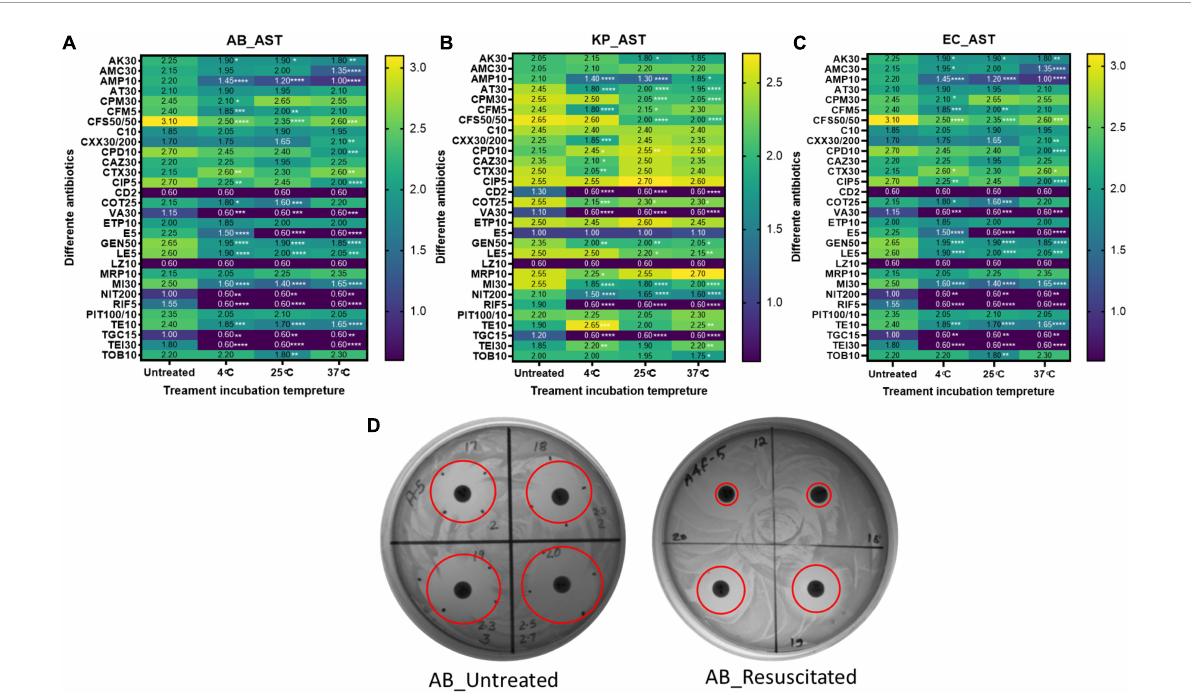
FIGURE6 AST profiling. The antimicrobial susceptibility pattern of resuscitated bacteria was checked by the disk diffusion method. AST pattern on the basis of the zone of inhibition diameter among untreated and formic acid (FA)-treated cells at 4, 25, and 37 ◦ C for panel (A) Acinetobacter baumannii , (B) Klebsiella pneumoniae , and (C) E. coli are shown here. Panel (D) is a representation of the disk diffusion agar plate of FA treatment at 4 ◦ C in A. baumannii with reduced clear zone diameter (in cm) in resuscitated bacteria. Statistical significance of diameter changes was determined by two-way ANOVA with multiple comparison followed by correction with Dunnett’s multiple comparison test using GraphPad Prism version 9.0.0. FA, formic acid; GC, growing control; NVC, non-viable control; 4C, sample incubated at 4 ◦ C; 25C, sample incubated at 25 ◦ C; 37C, sample incubated at 37 ◦ C; AB, Acinetobacter baumannii ; KP, K. pneumoniae ; EC, E. coli ; AK30, Amikacin (disk); AMC30, Amoxiclav (Amoxicillin/Clavulanic acid) disk; AMP-10, Ampicillin (disk); AT-30, Aztreonam disks; CPM50, cefepime disk; CFM5, Cefixime (disk); CFS 50/50, Cefoperazone (Sulbactam) disks; C10, Cefotaxime disks; CXX 30/200, Cefoxitin/Cloxacillin disks; CPD10, Cefpodoxime disks; CAZ30, Ceftazidime (disk); CTX30, Chloramphenicol disks; CIP5, Ciprofloxacin (disk); CD2, Clindamycin (disk); CO25, Co-Trimoxazole (sulfa/trimethoprim) disks; VA30, Vancomycin (disk); ETP10, Ertapenem (disk); E5, Erythromycin-1V disk; GEN50, Gentamycin (disk); LE5, Levofloxacin disk; LZ10, Linezolid (disk); MRP10, Meropenem (disk); MI30, Minocycline disk; NIT200, Nitrofurantoin disks; RIF-5, Rifampicin disks; PIT 100/10, Tazobactam/Piperacillin disks; TE 10, Teicoplanin disks; TGC-15, Tigecycline (disk); TOB 10, Tobramycin disk; TEI 30, Tetracycline (disk). *Represents P -valve < 0.5, ** P -valve < 0.05, *** P -valve < 0.005, and **** P -valve <